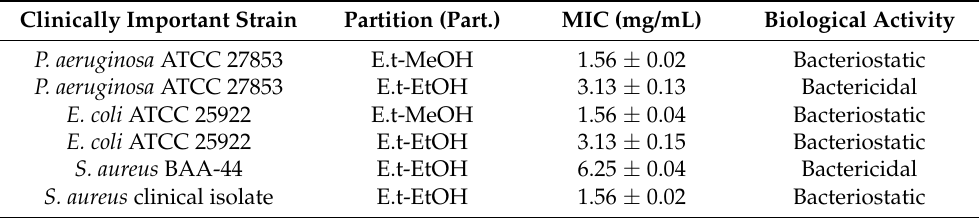
Table 3. Determination of the minimum inhibitory concentrations (MICs) of the alcoholic partitions of E. tirucalli , and the corresponding types of biological